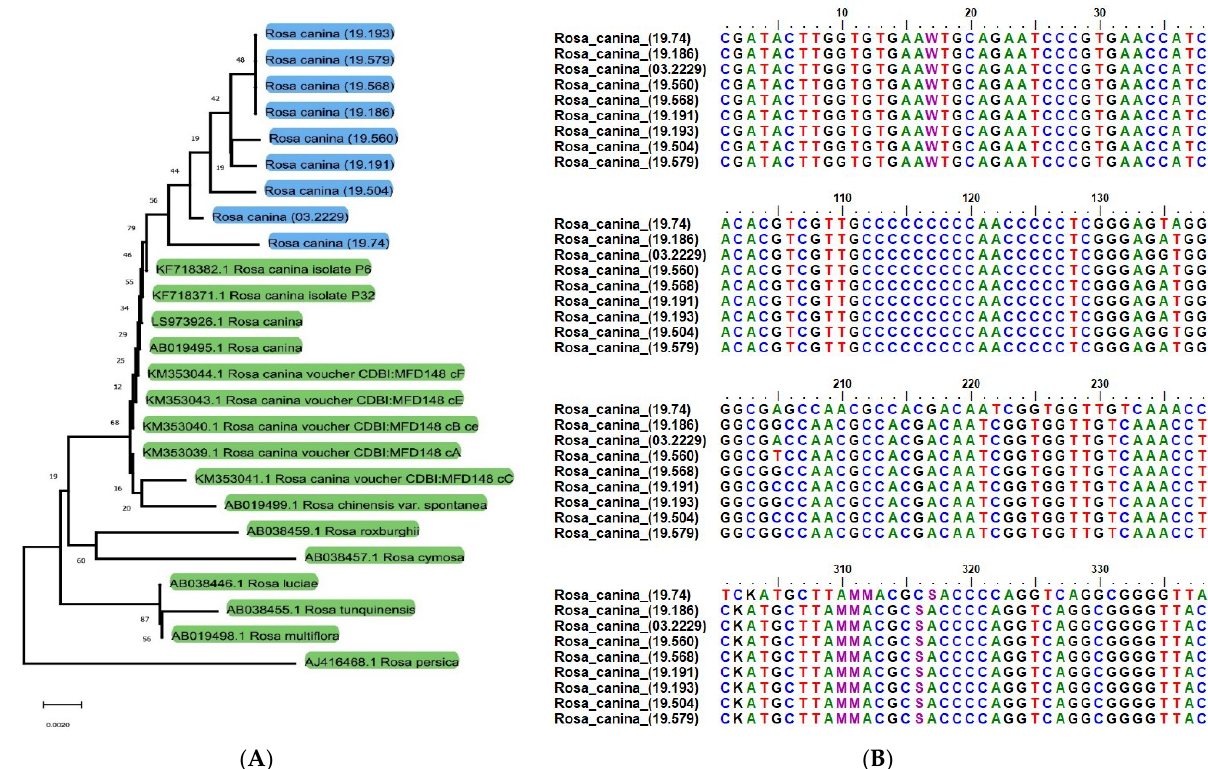
Figure 1. Phylogenetic tree ( A ) constructed on the basis of ITS2 regions of the Greek native Rosa canina genotypes contrasted with other R. canina and Rosa spp. genotypes retrieved from NCBI with multiple sequence alignment of the ITS2 barcode region of the genotypes analyzed in this study ( B ). Results from neighbor-joining (NJ) bootstrap analyses with 500 replicates was used to assess the strength of the nodes. The node numbers indicated the bootstrap value of NJ. The distinct genotypes of this study are highlighted with blue.